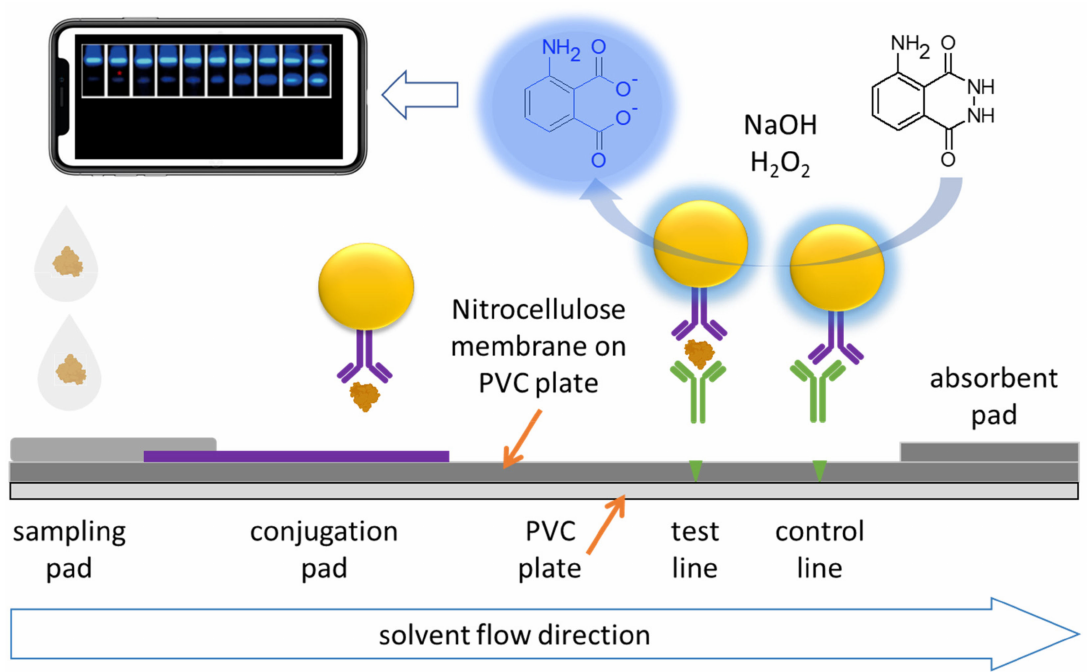
Figure 15. Illustration of the chemiluminescence nanozyme-linked immunoassay paper strip developed and tested by Liu et al., (2020) in the detection and identification of the SARS-CoV2 S-RBD